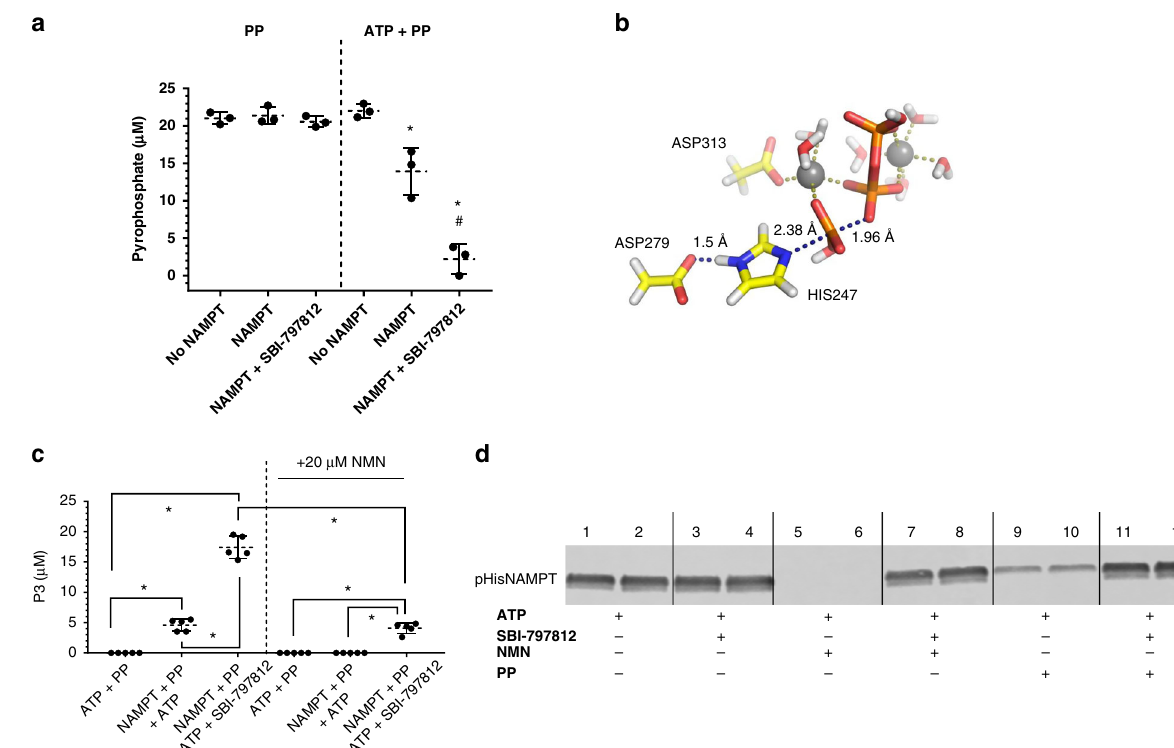
Fig. 3 SBI-797812 impacts PP consumption and pHisNAMPT reactivity. a SBI-797812 stimulates NAMPT-mediated PP consumption. NAMPT (100 nM) was incubated with ATP (2 mM), PP (20 μ M) or ATP + PP for 2 h at 37 °C in TMD buffer. Where indicated, SBI-797812 (5 μ M) was also included. Samples assayed for PP using the colorimetric assay. Data expressed as means ± s.d.; n = 3. * p < 0.001 vs. No NAMPT (ATP + PP); # p < 0.001 vs. NAMPT (ATP + PP). One-way ANOVA with Tukey ’ s multiple comparisons test. b Transition structure of the predicted reaction between pHisNAMPT and PP. The computational model used an original X-ray data set (PDB: 3DHF and 3DKL): pHis247, residues Asp313 and Asp279 are mimicked by acetate groups, two magnesium atoms (grey spheres) were incorporated to coordinate PP along with water molecules. The catalyzed reaction proceeds via late S N 2 attack of the pHis247 with d N – P = 2.38 Å and d P – O = 1.96 Å (blue dashed lines). c Production of P3 from ATP and PP by NAMPT. NAMPT incubated for 2 h with